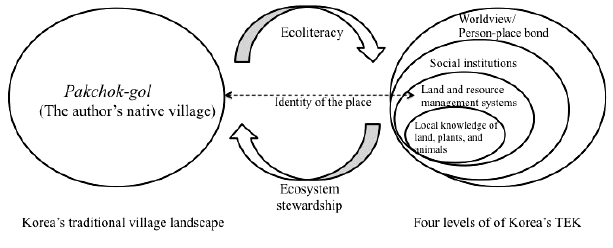
Fig. 2 . Summary of Korea’s traditional ecological knowledge (TEK) based on the analysis of Park’s (2009) autobiographical novel (adapted from Berkes